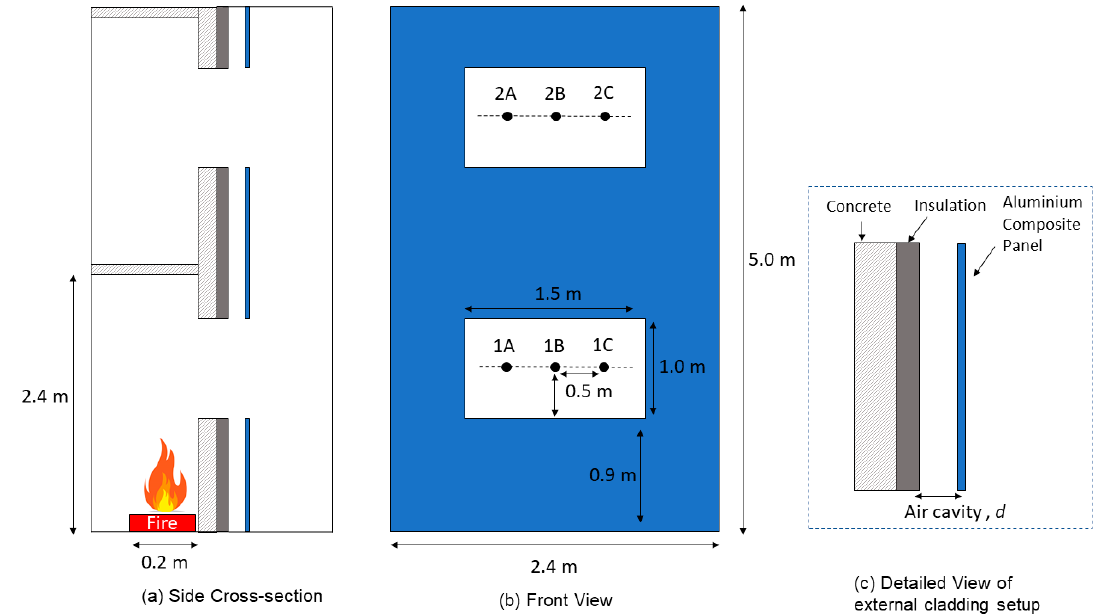
Figure 4. Model Figure 4. Model configuration.